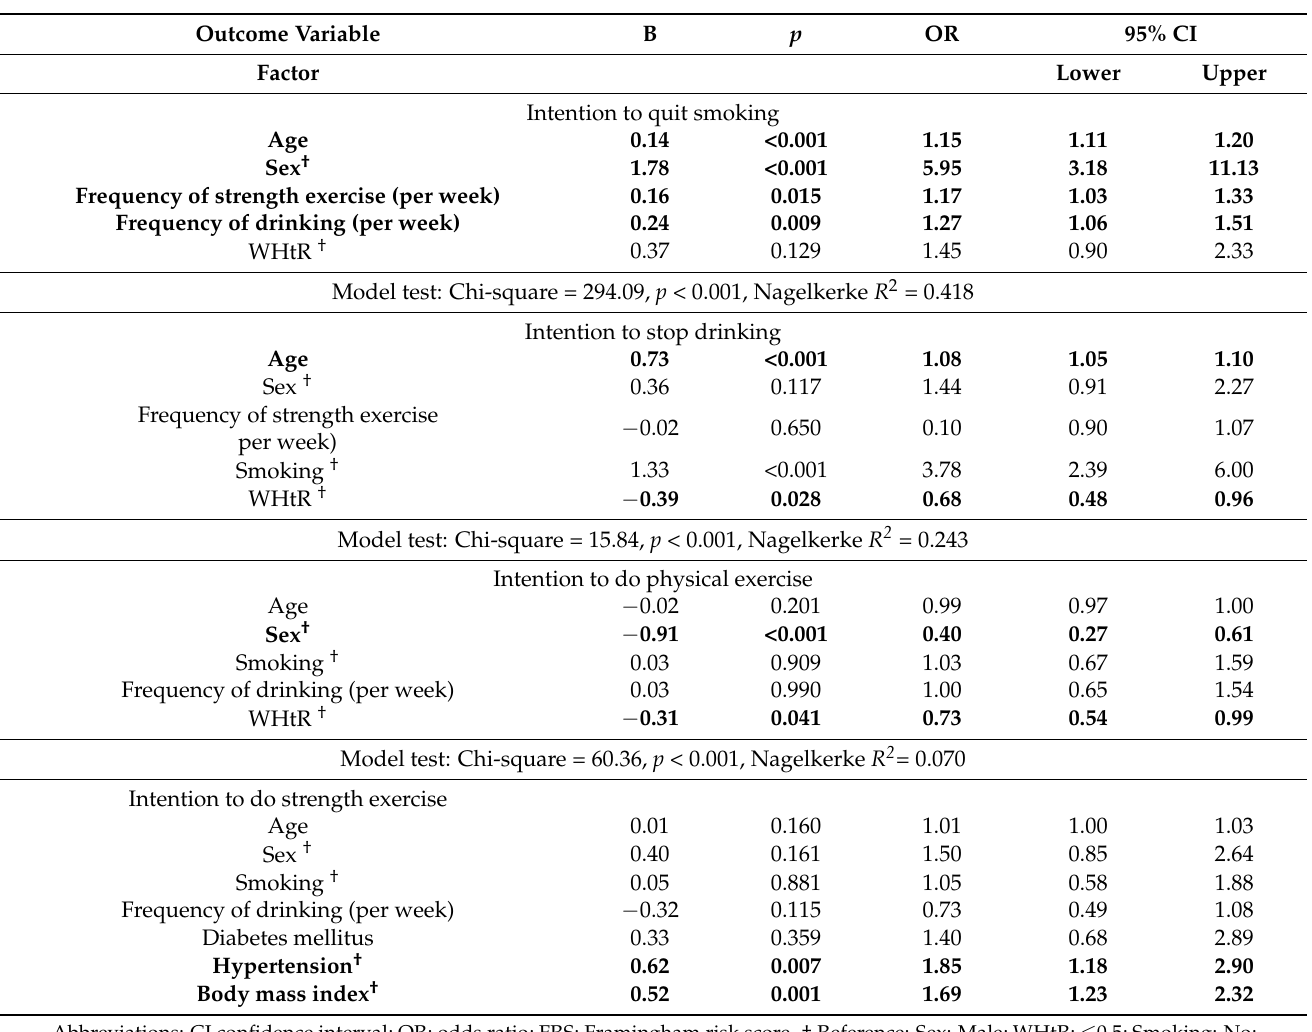
Table 3. Predictors of intention to modify lifestyle in at-risk CVD groups (N =